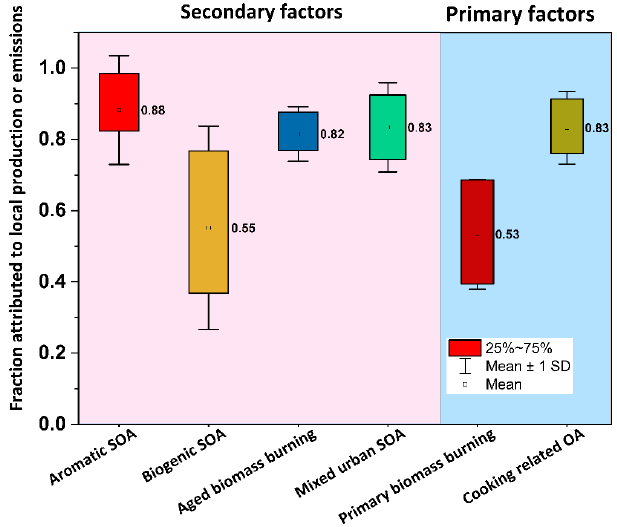
Figure 5. Box-and-whisker plots showing the fraction of daytime local production (SOA) or emissions (POA) for EESI-TOF factors. The values averaged over all days for all factors are depicted by numbers adjacent to each box. For the ease of viewing, background shading denotes SOA (pink) and POA (blue)